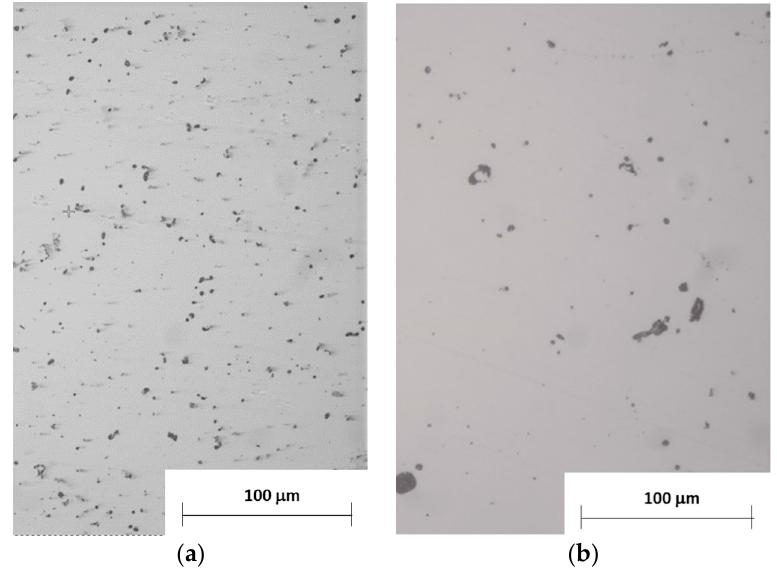
Figure 7. Optical microscopy micrograph of the mirror-polished surfaces: ( a ) D1; ( b ) D2 (in one of the location were porosities concentrated).